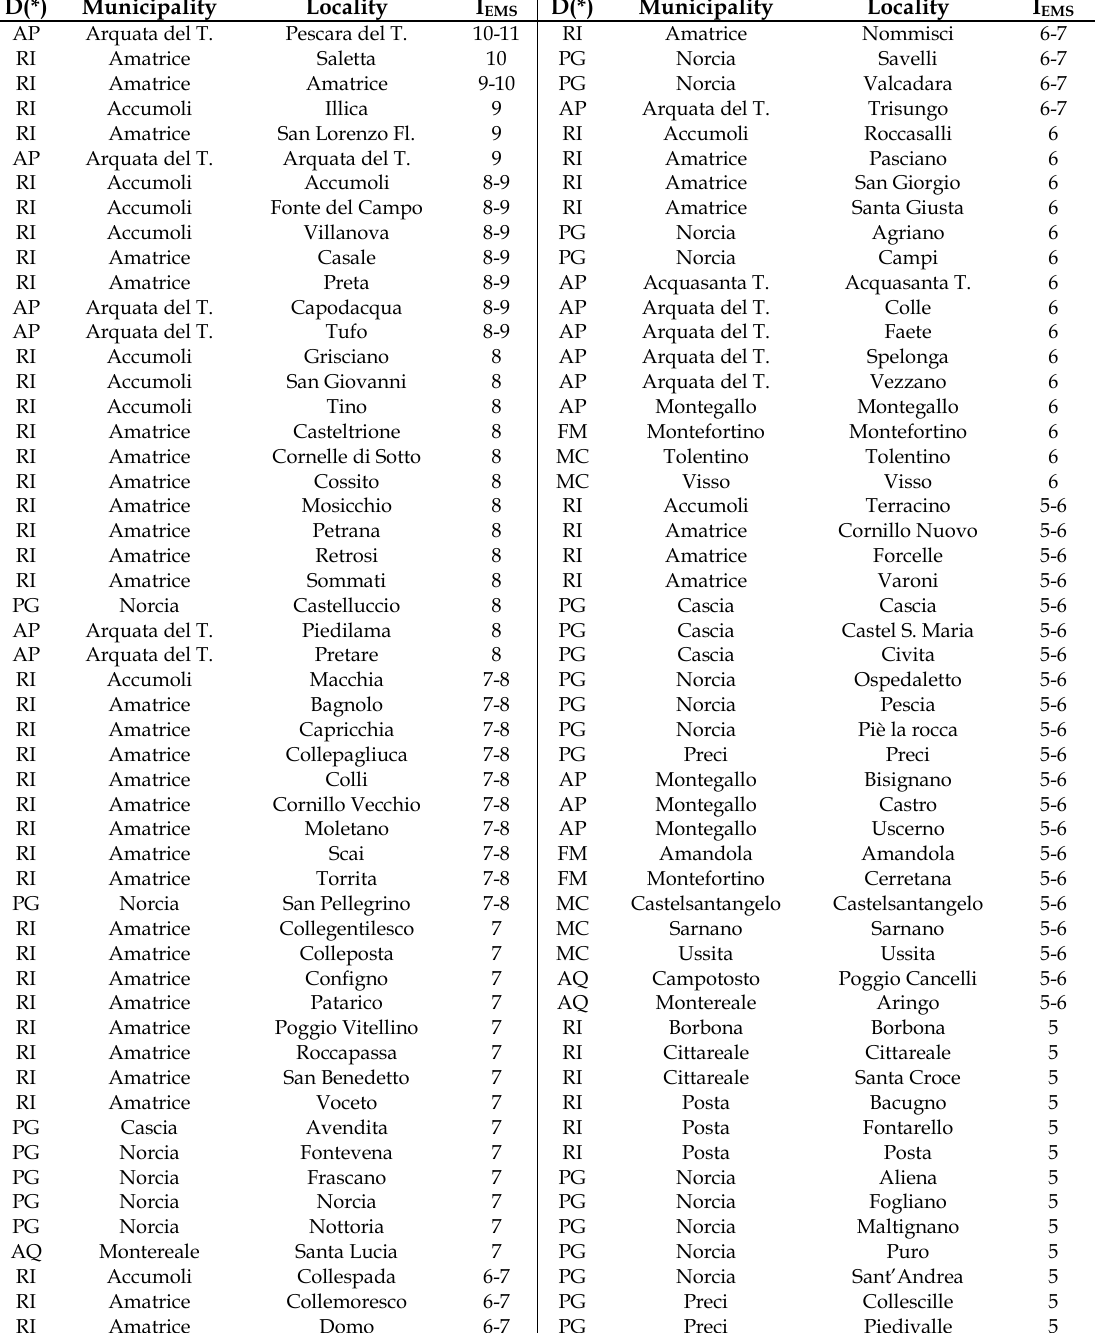
Table 1: Localities surveyed after the August 2016 seismic